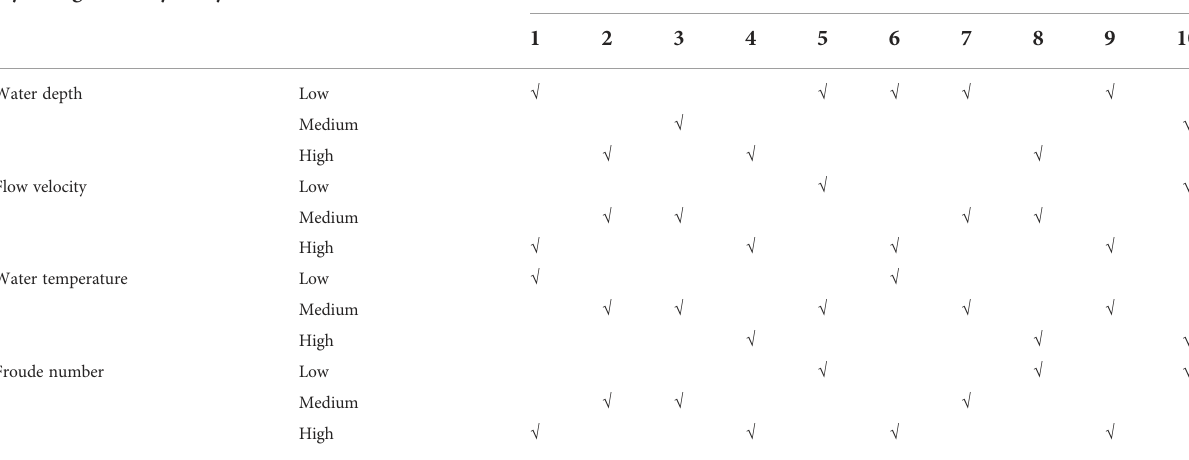
TABLE 4 Hydrologic and hydrodynamic characteristics of the 10